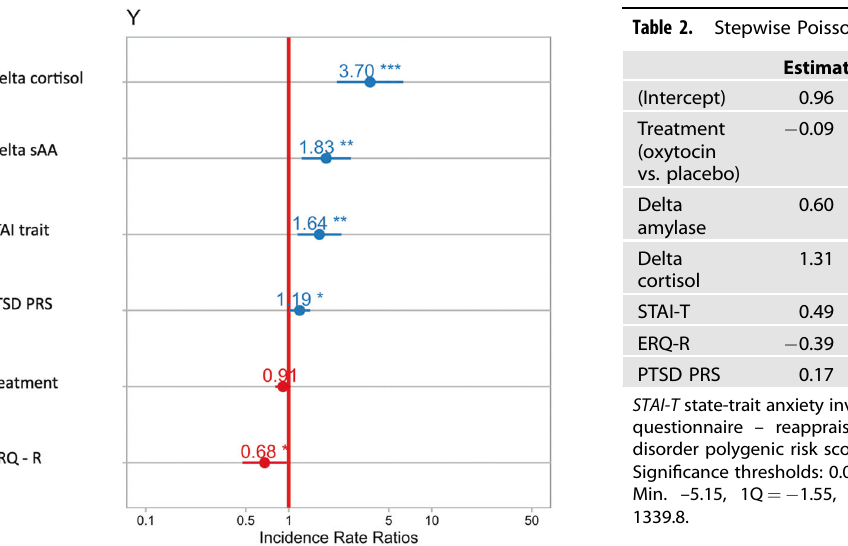
Fig. 3 Coef fi cient estimates of the step-wise poisson regression (see Table 2). Signi fi cant effects are marked by an asterisks (* < 0.05, ** < 0.01, *** < 0.001). Highest coef fi cients are plotted on top, vertical red line indicates the intercept of “ no effect ” . STAI trait state-trait